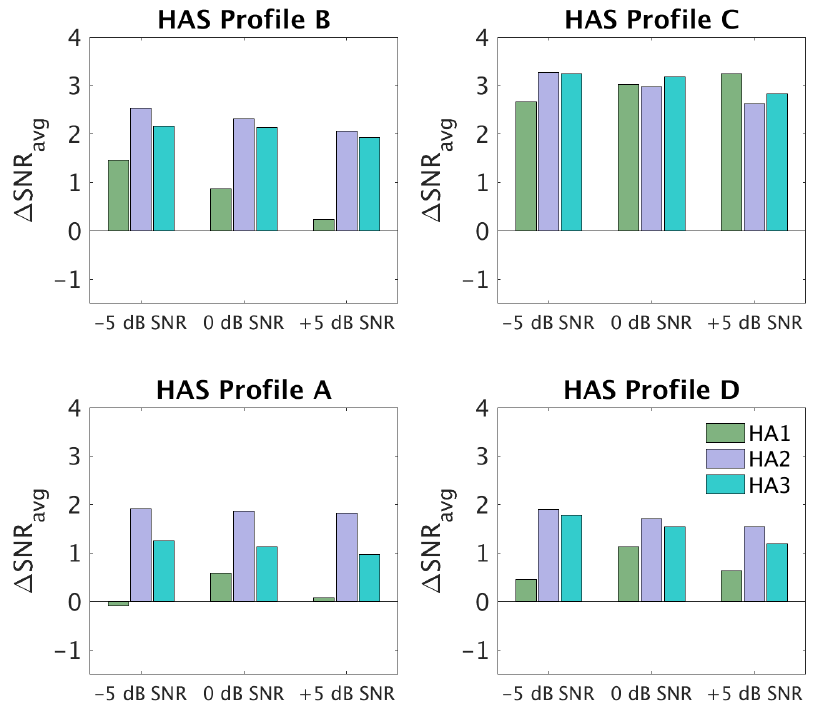
Figure 5. SNR improvement ( Δ SNR avg ) measured at three input SNRs ( − 5, 0, +5 dB) for the four auditory profile-based HA fittings (A–D) and three different HAs (HA1, HA2, HA3). auditory profile-based HA fittings (A–D) and three different HAs (HA1, HA2,